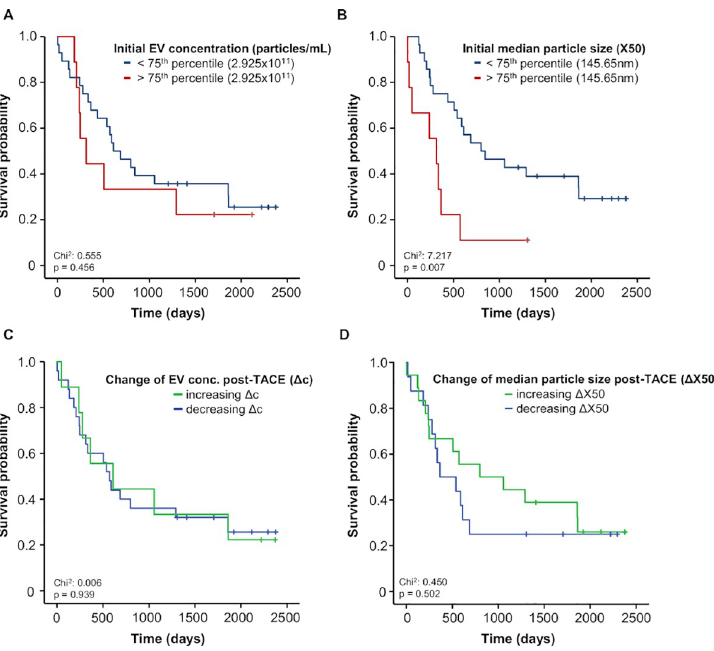
Fig 4. Elevated baseline median particle size predicts an unfavorable outcome after TACE. (A) Initial EVS concentration does not predict overall survival in patients with primary or secondary hepatic cancer. (B) Patients with an initial median particle size (X50) above the 75 th percentile (145,65nm) shows a significantly impaired post- interventional survival. (C+D) Increases and decreases of EVs concentrations and median particle sizes (X50) between baseline and day 1 after TACE do not predict overall survival in patients with primary or secondary hepatic cancer.